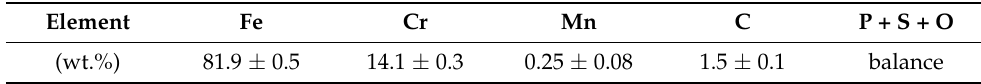
Table 2. Chemical composition of 420 stainless steel measured by EDS.